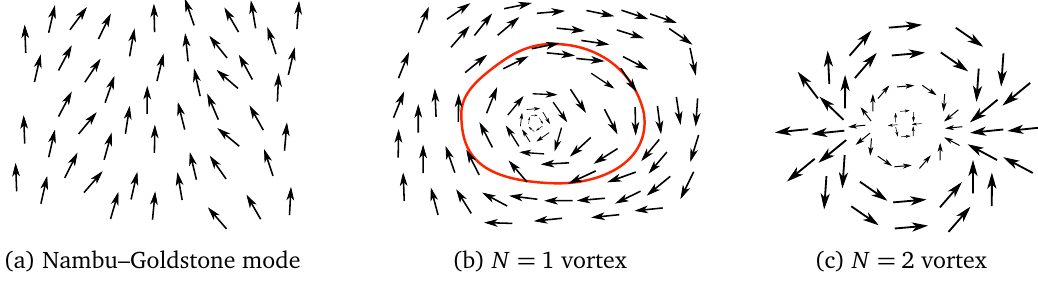
Figure 6.1: Left: X Y -model SSB state perturbed by NG modes. Centre: a single vortex with winding number one. Following the red contour, spins wind by 2 π , independent of the position and shape of the contour, as long as it encloses the vortex core. At the vortex core, the phase in not defined: there is a singularity. If the size of the spins can vary, it will shrink to zero at the core. Right: a single vortex with winding number